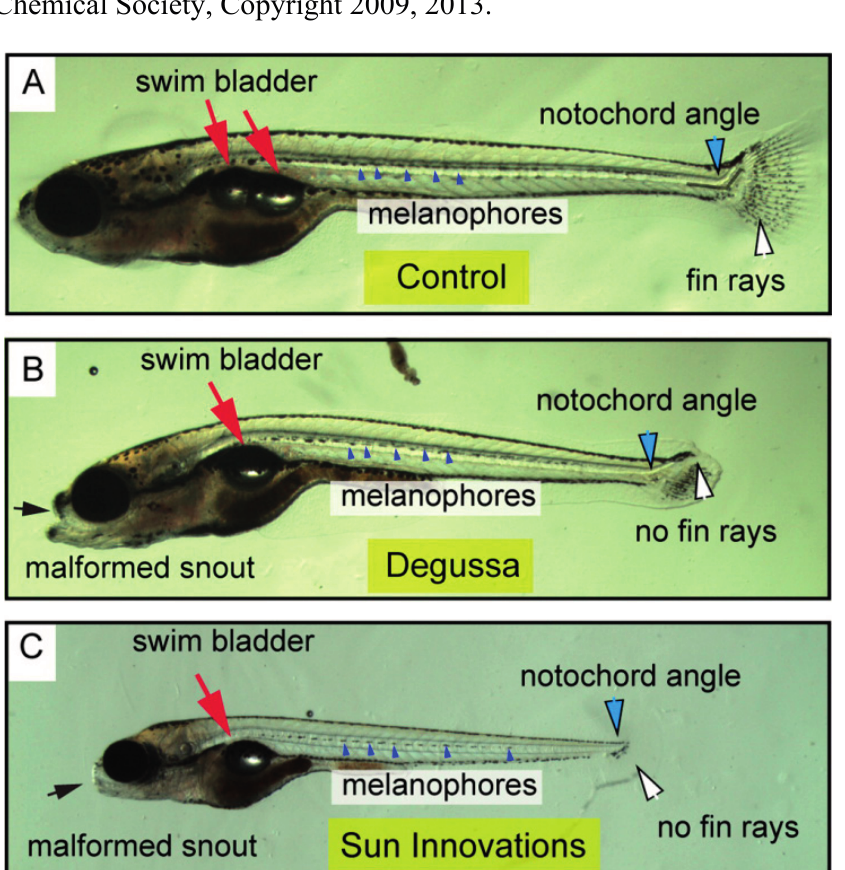
Figure 3. TNP (titanium dioxide nanoparticle) exposure-induced photodependent delays in development, decreased growth, and tissue malformation and possible mechanisms. Fish were exposed to illumination in all cases with ( A ) water as a control; ( B ) Degussa TNPs (1 ng/mL); or ( C ) Sun Innovations TNPs (1 ng/mL). Representative effects of the TNPs were indicated. The red arrows show the normal bi-lobed swim bladder in the control and the single-lobed swim bladder in the treated fish. The small blue points indicate the row of developing melanophores making an unbroken line in the normal fish, and underdeveloped in the treated fish. Fin rays in the normal fish are indicated by a white arrow, and the angle of the notochord as it intersects the caudal fin is indicated by a black line and blue arrow. The black arrow indicates the snout shortening and related craniofacial malformations caused by treatment. Possible mechanisms of illumination-induced ROS (reactive oxygen species) generation were performed in ( D ). Adapted from [110,111] with permissions from the American Chemical Society, Copyright 2009,